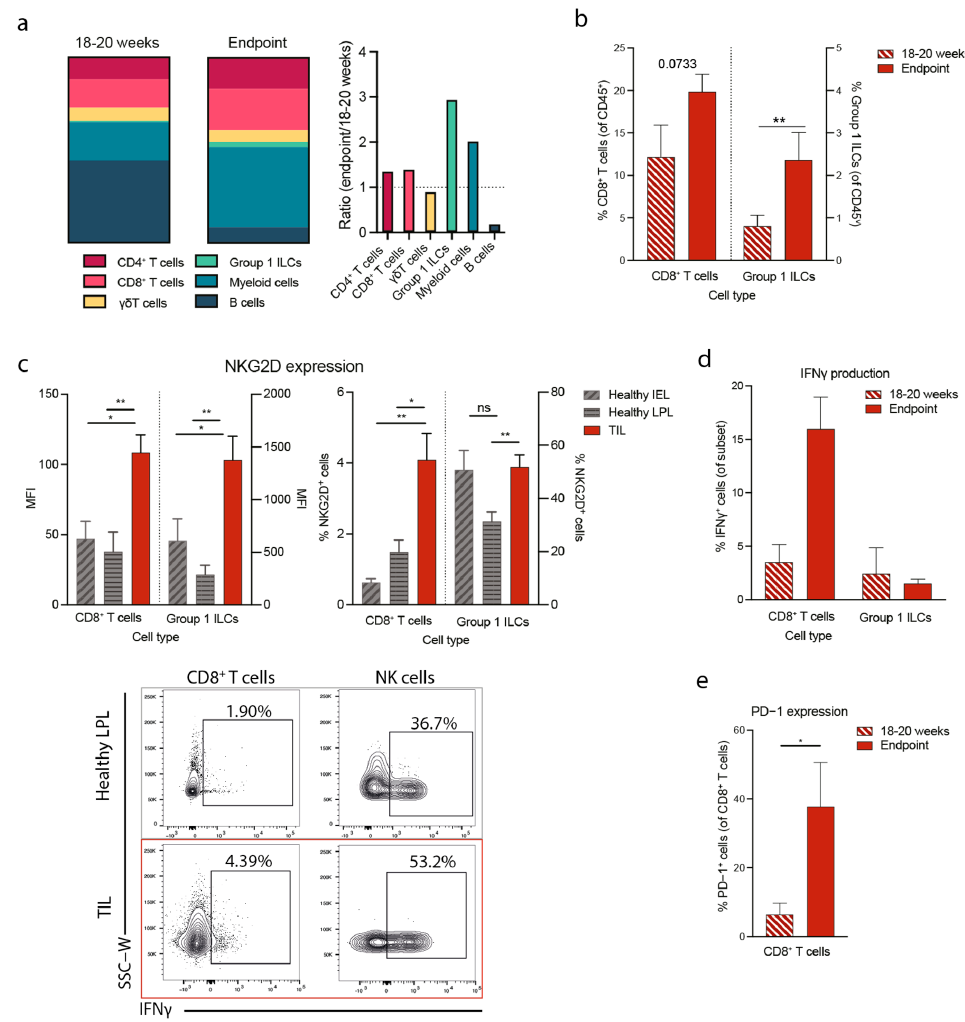
Figure 3. Disease progression in Apc min/+ mice is associated with an increased proportion of IFN γ - producing CD8 + T cells in the TME. ( a ) Immune composition of Apc min/+ mice at 18–20 weeks (left) and disease endpoint (middle) and ratio between 18–20 weeks and endpoint (right). Cells were gated on Live CD45 + lymphocytes with subsequent gating as follows: CD4 + T cells: CD3 + CD4 + , CD8 + T cells: CD3 + CD8 + , γδ T cells: CD3 + TCR δ + , Myeloid cells: CD3 − CD19 − NK1.1 − CD11b + and B cells: B220 + CD11b − ( b ) Percentages of CD8 + T cells (left) and Group 1 ILCs (right) at 18–20 weeks and disease endpoint. ( c ) MFI of NKG2D (left) and percentage of NKG2D-expressing cells within each subset (right) in healthy IEL, LPL and TIL at 18–20 weeks and representative flow cytometry plots showing IFN γ production by different cell subsets (bottom). ( d ) Percentages of tumor-infiltrating IFN γ -producing CD8 + T cells and Group 1 ILCs at 18–20 weeks and disease endpoint. ( e ) Per- centages of tumor-infiltrating PD-1-expressing CD8 + T cells at 18–20 weeks and disease endpoint. IEL = intraepithelial lymphocytes, LPL = lamina propria lymphocytes, TIL = tumor-infiltrating lym- phocytes, ILC = innate lymphoid cell, ns = not significant. Statistical significance was determined using a Mann–Whitney U or unpaired t-test following a Shapiro–Wilk normality test. Bars represent mean ± SEM. * p ≤ 0.05, ** p ≤